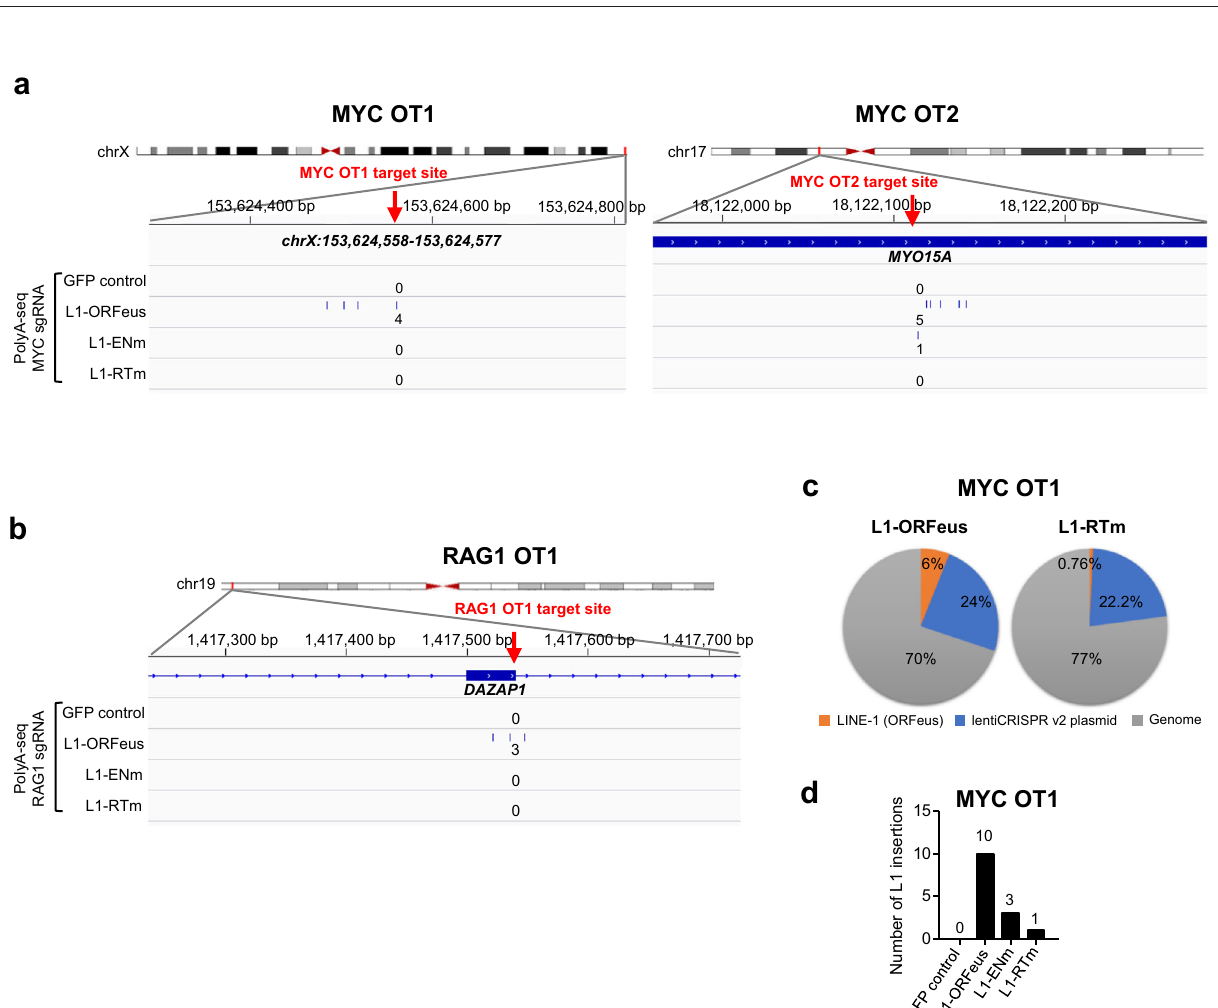
Fig. 3 EN consensus motif - independent de novo L1-ORFeus insertions at CRISPR/Cas9 target sites. a Distribution of 3 ′ Poly(A) tract lengths of L1- ORFeus insertions obtained by PolyA-seq in HEK293T cells expressing L1-ORFeus and targeted by MYC CRISPR/Cas9. b Numbers of L1-ORFeus insertions obtained by PolyA-seq at the MYC locus targeted by MYC CRISPR/Cas9 ( b , left) or at the RAG1 locus targeted by RAG1 CRISPR/Cas9 ( b , right) in HEK293T cells expressing L1-ORFeus, L1-ENm, L1-RTm, or GFP control. c Detailed view of the distribution of L1-ORFeus insertions at the MYC locus obtained by PolyA-seq in HEK293T cells targeted by MYC CRISPR/Cas9 expressing L1-ORFeus, L1-ENm, L1-RTm, or GFP control. Each line corresponds to an independent L1-ORFeus insertion; number of L1-ORFeus insertions is pooled from two independent PolyA-seq. Corresponding GRO-seq, ChIP-seq (including Pol II, H3K4me3, and H3K27ac), and ATAC-seq pro fi les are shown ( c , bottom). Red arrow shows the MYC CRISPR/Cas9 target site. d Top: Sequence logo representing the consensus motif detected at L1-ORFeus pre-integration sites in example regions proximal or distant to the MYC CRISPR/ Cas9 DSB. Each dot represents a chromosomal region encompassing 30 independent L1-ORFeus insertions. Bottom: Spline interpolation curve of consensus motif position-weighted matrix (PWM) score in chromosome 8 obtained by PolyA-seq in HEK293T cells targeted by MYC CRISPR/Cas9 that express L1-ORFeus. The mean interval size covered by the chromosomal region encompassing 30 independent L1-ORFeus insertions was 1353.5 bp (range 198 – 8440 bp) within approx. ±5 kb of the MYC CRISPR/Cas9 target site, and 2,824,123 bp (range 801,848 – 6,764,412 bp) outside of the CRISPR/Cas9 target site.